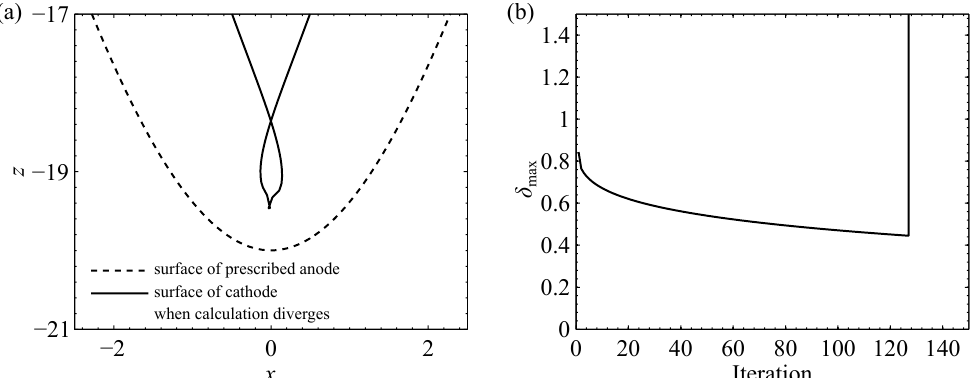
Figure 6. Numerical cathode shape design procedure applied to a problem without physically meaningful solution (spatial dimensions are normalized to the width of the standard equilibrium front gap). Panel ( a ) shows the degenerated cathode surface profile near x = 0. Panel ( b ) shows the evolution of the convergence measure, δ max (cf. Equation (14)). The sudden increase after 130 iterations is attributed to the error resulting from the degenerated